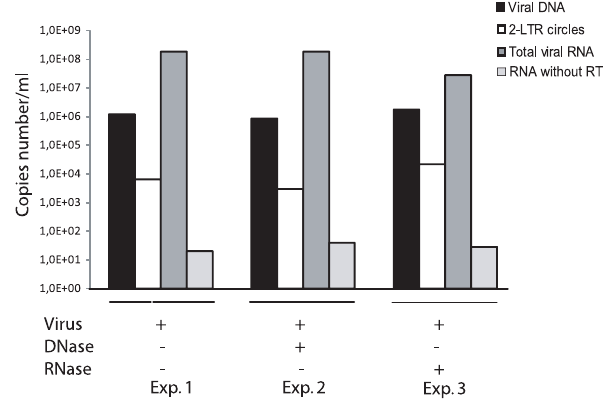
Figure 1. Characterization of the nucleic acid content of purified PFV particles. Copy numbers of DNA (linear and 2-LTR circles) and RNA were determined by real-time PCR and RT-PCR. Each quantification has been performed in triplicate. However, the standard deviation is too weak to be indicated. Viral supernatants were treated with DNase or RNase. The quantification of viral RNA without reverse transcription is indicated as a control. Results were expressed in copies per ml of